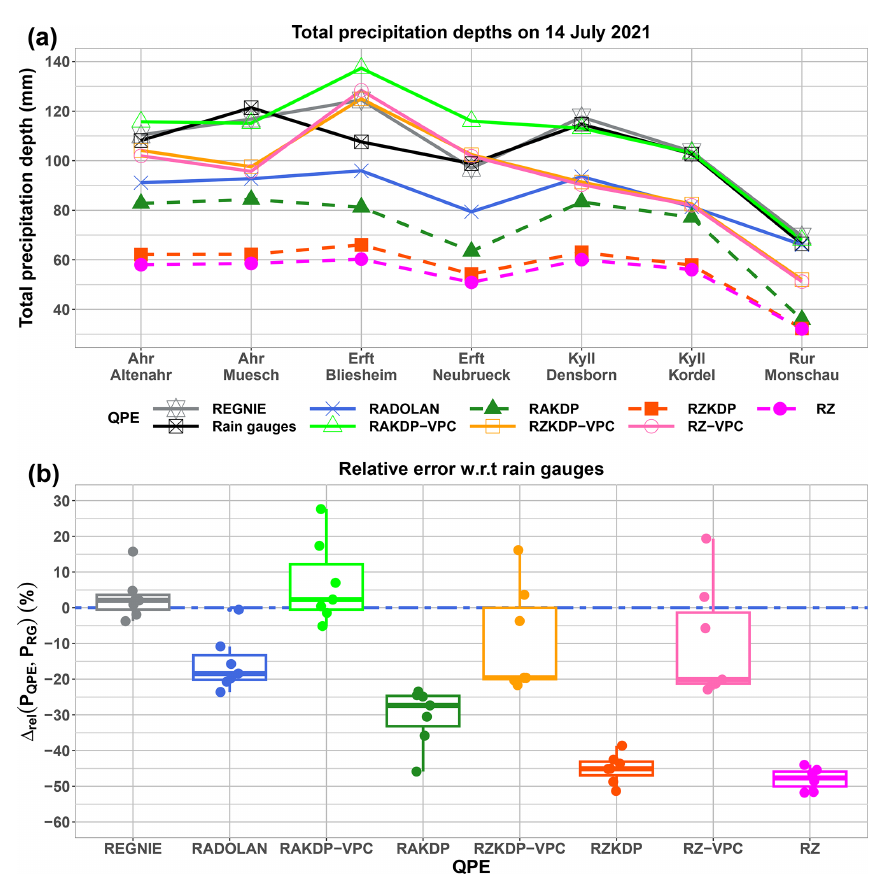
Figure 4. (a) Total precipitation depths for 14 July 2021 estimated by rain gauges, REGNIE, and radar-based QPE products. (b) Relative errors in REGNIE and radar-based QPEs with respect to (w.r.t) estimates from rain gauges using Thiessen polygons of the total catchment- scale precipitation depth for 14 July